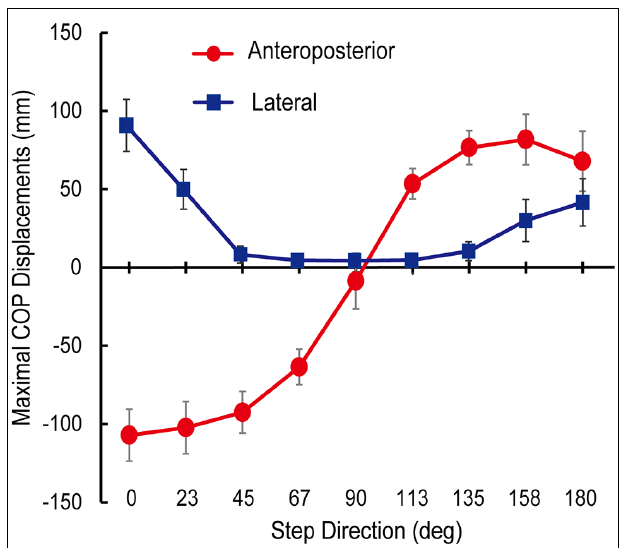
FIGURE 2 | Maximal anteroposterior (red) and lateral (blue) displacements of the center of pressure under feet (COP) during anticipatory postural adjustment (APA) phase from COP position at a quiet stance (mean ± standard deviation of all subjects). Both maximal anteroposterior and lateral COP displacements were significantly different between the stepping directions ( P < 0.05).